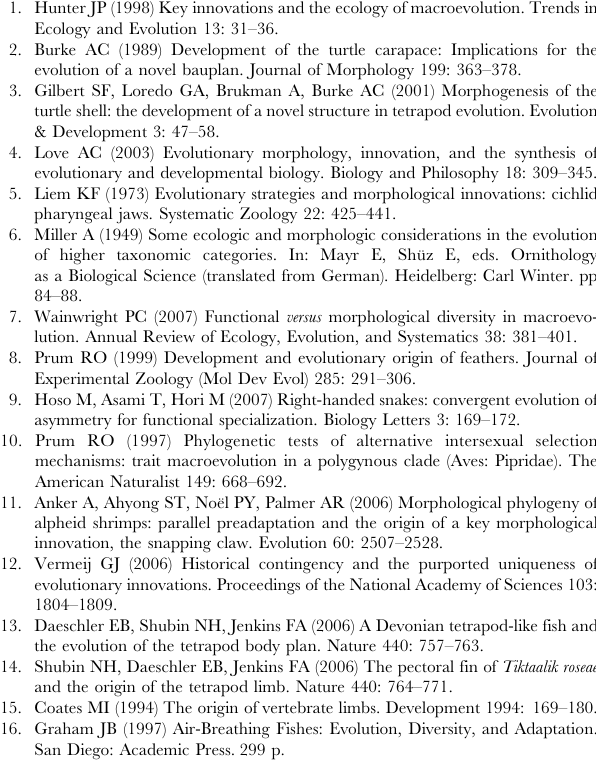
Table S1 Eigenvector results for each of the principal compo- nents in the preparatory and propulsive kinematic models. Table S2 Features selected by stepwise linear discriminant analysis.